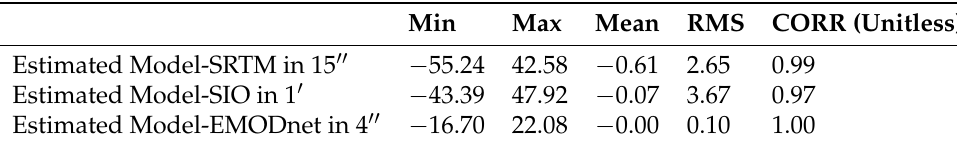
Table 5. Seafloor topography differences between the estimated model and existing models (unit: m).